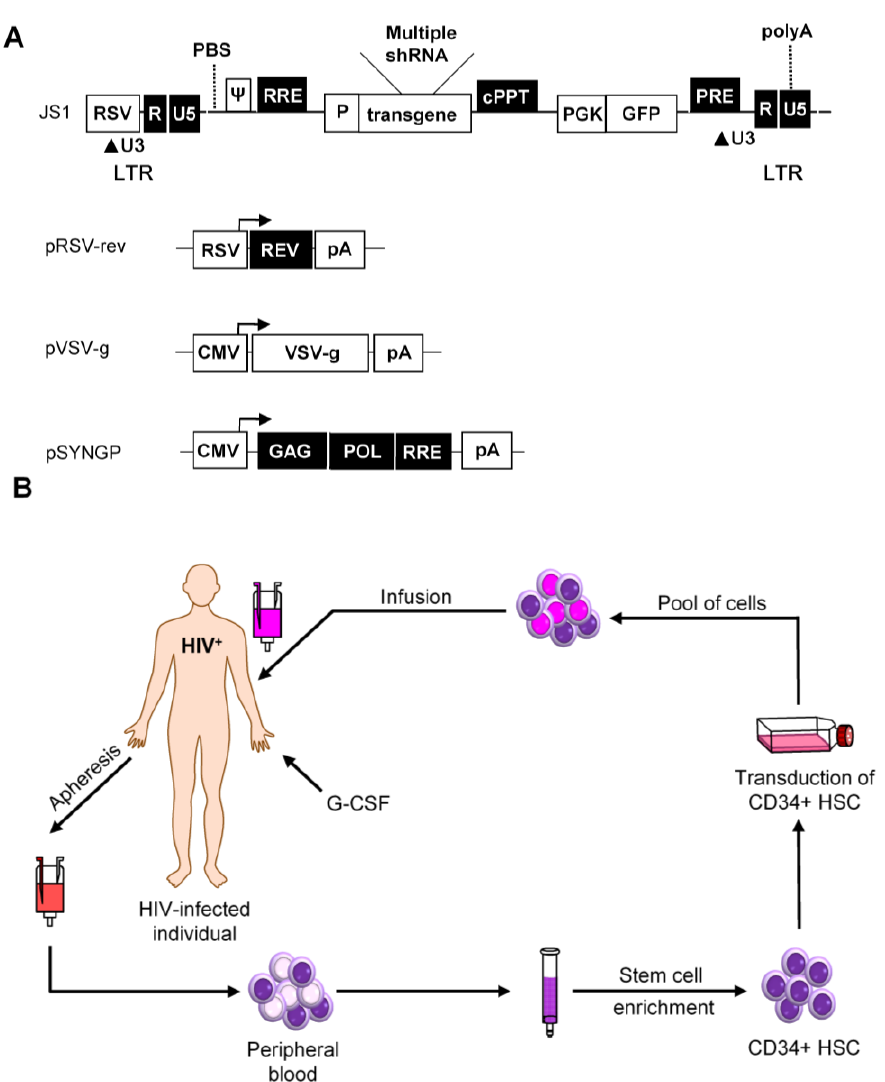
Figure 5. Self-inactivating lentiviral vectors for stable shRNA expression. ( A ) The lentiviral vector JS1 is shown with three plasmids needed for lentiviral vector production. The vector genome is expressed from the Rous Sarcoma Virus (RSV) promoter. Transcripts start with the HIV-1 R and U5 regions and the packaging signal ( ψ ). The enhanced green fluorescent protein (GFP) reporter is expressed from the phosphoglycerate kinase promoter (PGK). Transcription of the vector genome and the GFP reporter terminates at the HIV-1 polyA signal within the 3′ LTR; ( B ) Scheme of a hematopoietic stem cell (HSC) clinical trial. An HIV-infected patient who fails on regular drug therapy will undergo apheresis for the collection of CD34 ` HSC after pretreatment with granulocyte-colony stimulatory factor (G-CSF). The mixed cell population containing CD34 ` HSC will be purified and transduced ex vivo with the therapeutic construct. Transduced cells will be infused back into the patient and the antiviral gene should protect these cells against